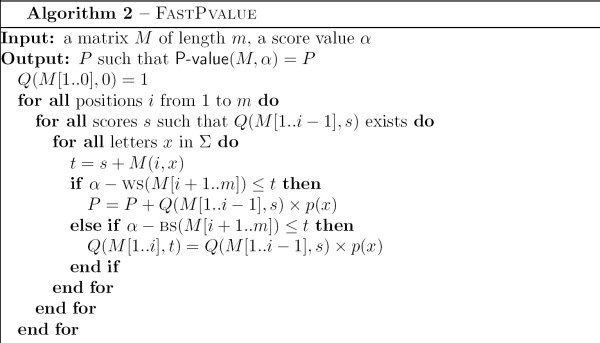
Algorithm FastPvalue.